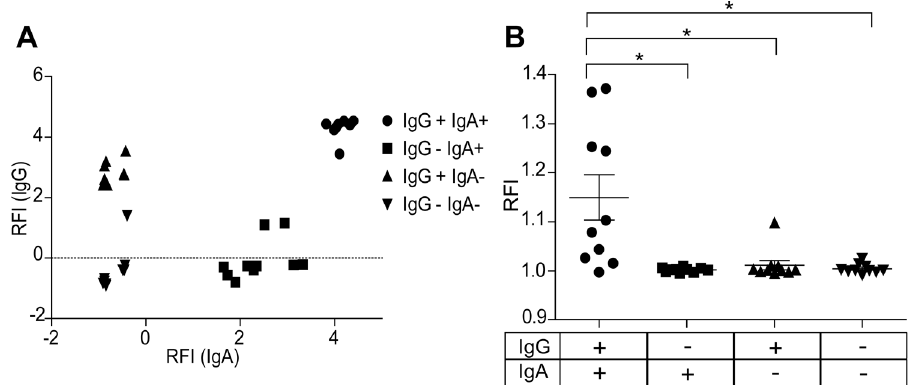
Fig 6. ACPA detection with the reporter cells. IgG and IgA reactivities of RA patients ’ sera were measured for VCP2 peptide on protein microarray (A). The reactivity was analyzed with anti-IgG and anti-IgA antibodies, and the results were presented in relative fluorescence intensity (RFI). Ten times diluted RA serum samples were incubated on VCP2 peptide coat, and then U937-NF- κ B cells were placed to the immuncomplex formed surface. The cell activation was normalized to the untreated cells (on BSA coat). Kruskal-Wallis and Dunn's multiple comparison tests were carried out to evaluate significant differences ( * p <